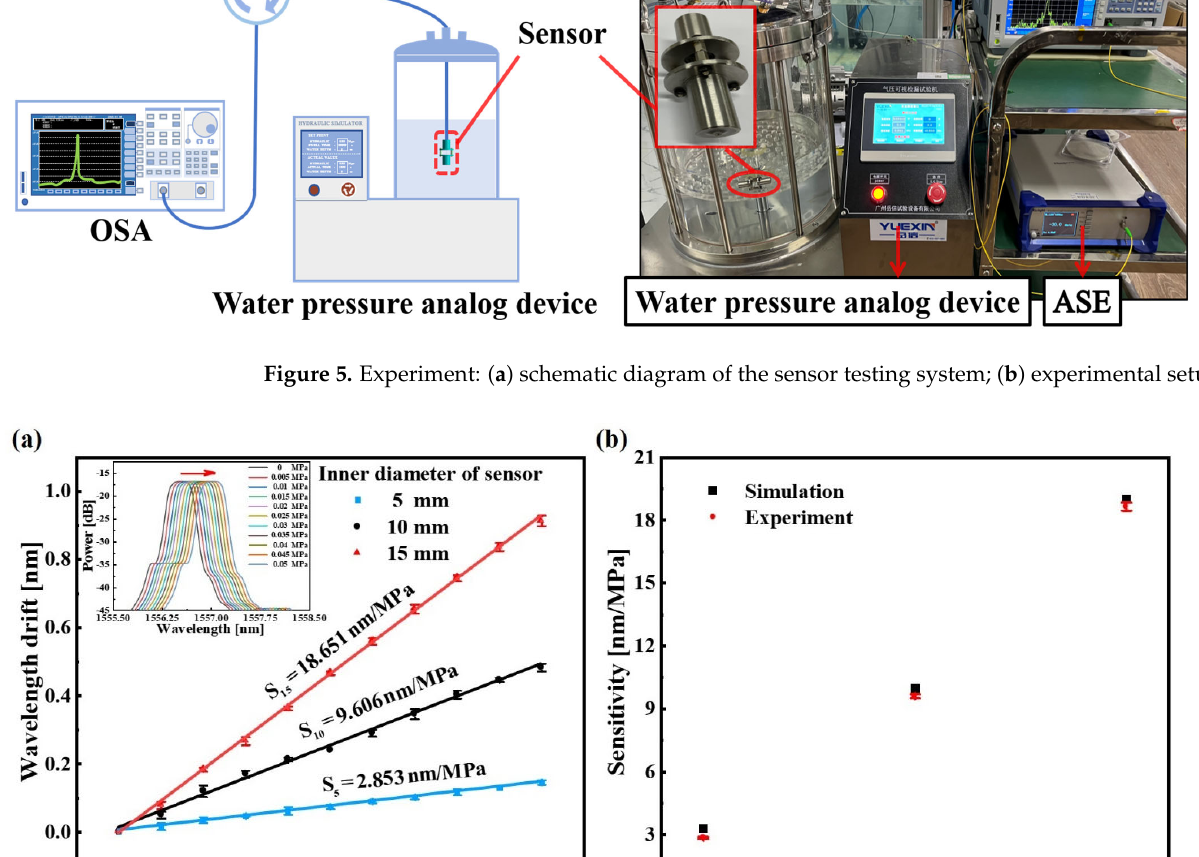
Figure 6. The liquid pressure testing results of the sensors: ( a ) linear fitting results of the sensors with inner diameters of 5 mm, 10 mm and 15 mm; ( b ) comparison of experimental results and simulation results of the sensors. The error bar is obtained by critically repeating the experiment of liquid pressure measurement three times.